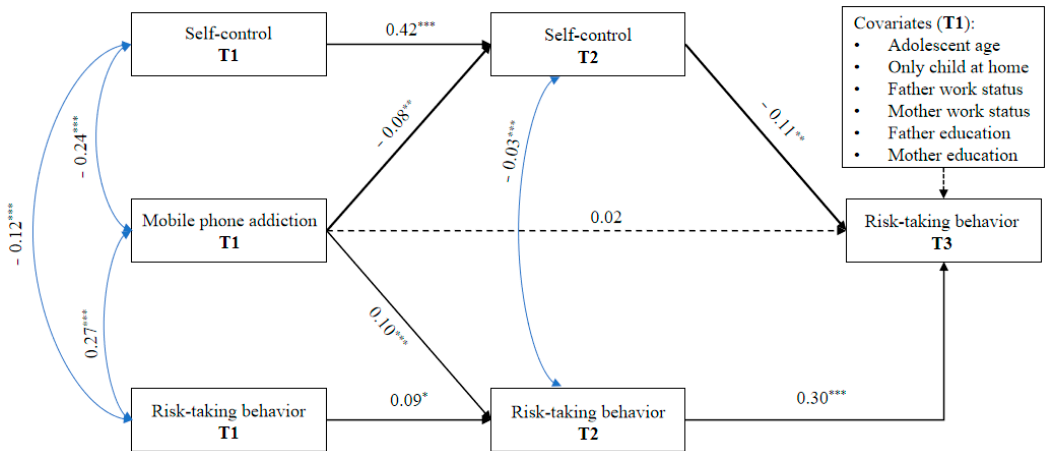
Figure 2. The mediation model of self-control in the association between mobile phone addiction and risk-taking behavior. Note: unstandardized estimates are presented; χ 2 = 36.91, df = 22, p < 0.05, root mean square error of approximation (RMSEA) = 0.041 with 90% CI [0.015, 0.064], comparative fit index (CFI) = 0.959, standardized root mean square residual (SRMR) = 0.039; * p < 0.05, ** p < 0.01, *** p < 0.001. Dashed line indicates a non-significant coefficient. Table 3. Regression model for the moderation e ff ect of adolescent sex. Self-Control (T2, R 2 = 0.29) Risk-Taking Behavior (T2, R 2 = 0.13) Risk-Taking Behavior (T3, R 2 =